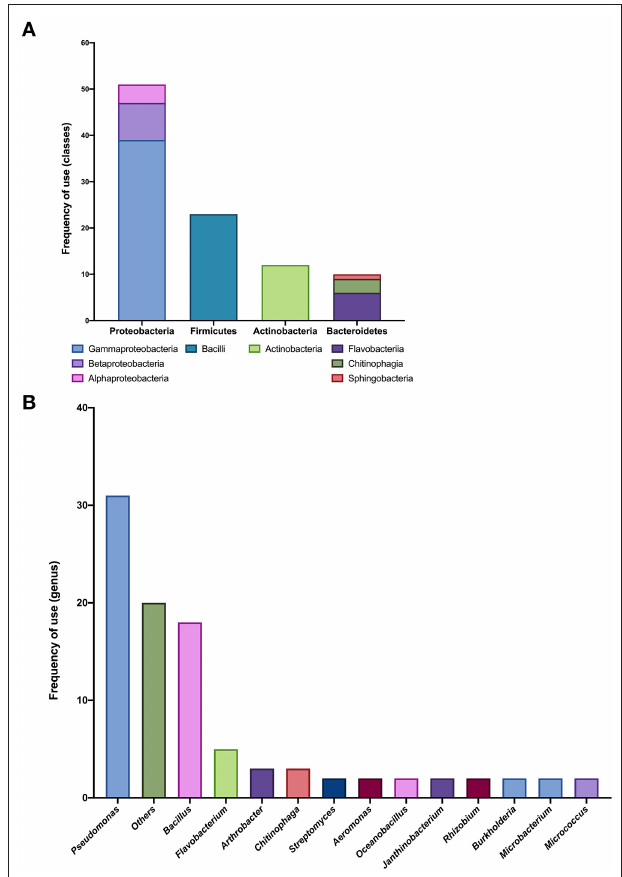
FIGURE 3 | Taxonomic analysis of small SynCom compositions. (A) Frequency of use (number of members) in different classes within each phylum from 15 reported small SynComs. (B) Frequency of use (number of members) in different genera from 15 reported small